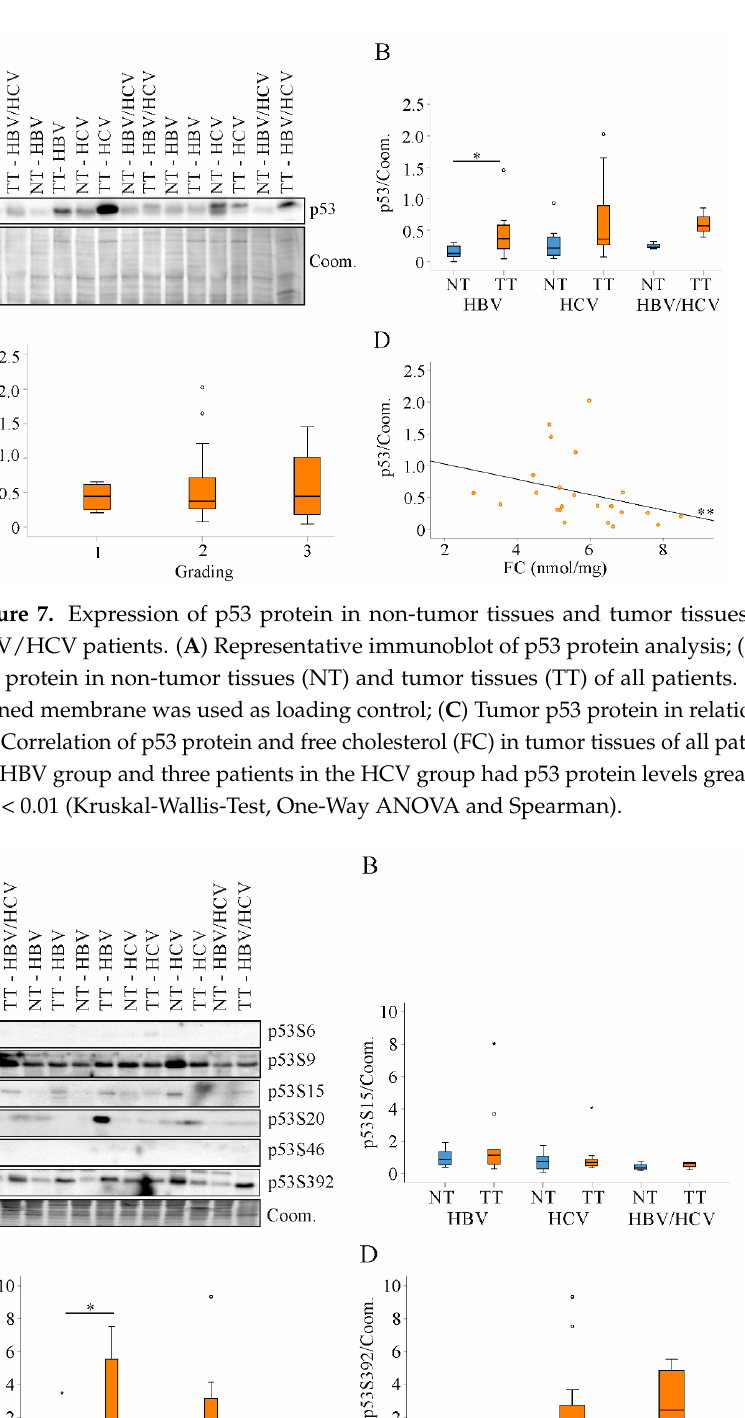
Figure 8. Expression of p53S6, S9, S15, S20, S46 and S392 protein in non-tumor tissues and tumor tissues of HBV, HCV and HBV/HCV patients. ( A ) Representative immunoblot of p53 protein analysis; ( B ) Quantification of p53S15 protein in non-tumor tissues (NT) and tumor tissues (TT) of all patients. Coomassie (Coom.) stained membrane was used as loading control; ( C ) Quantification of p53S392 protein in NT and TT of all patients. Coomassie (Coom.) stained membrane was used as loading control; ( D ) Tumor p53S392 protein in relation to tumor grading. * p < 0.05 (Kruskal-Wal- lis-Test, One-Way ANOVA). Table 2. Correlation of p53S9, S15, S20 and S392 with p53, free cholesterol, grading and T-stage in the HCC tissues of all patients. * p < 0.05, ** p < 0.01, *** p < 0.001. p53S9 p53S15